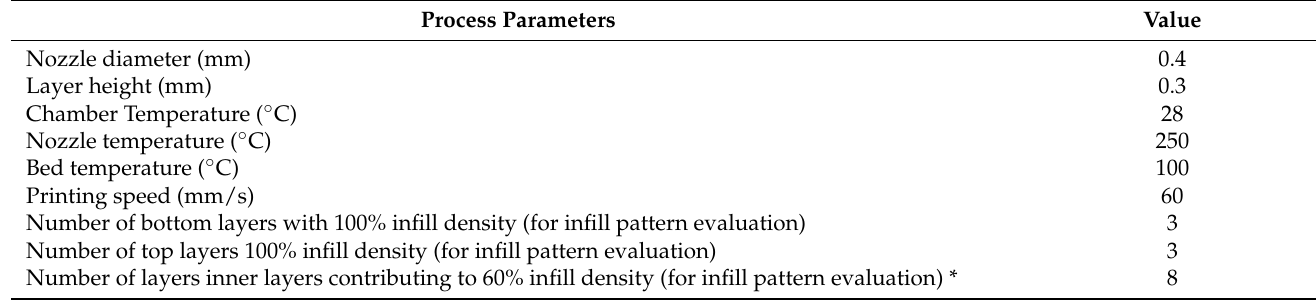
Figure 5. Infill patterns assessed in this study.